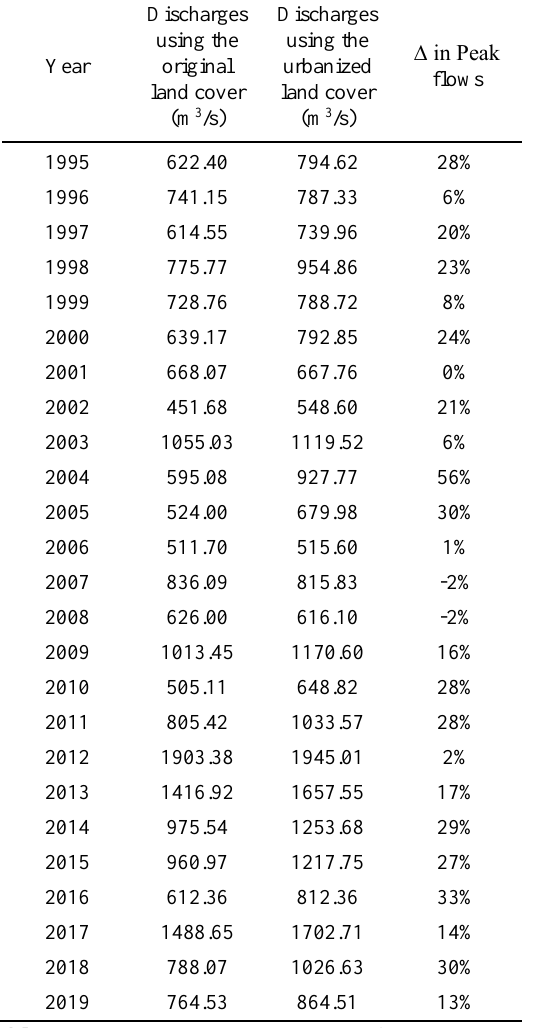
Table 4 . Annual Average Peak Discharges for Laguna de Bay Basin.